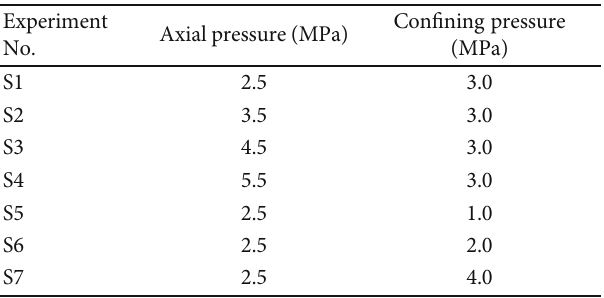
Table 1: Orthogonal experiment design for the SBCB permeability under di ff erent stress